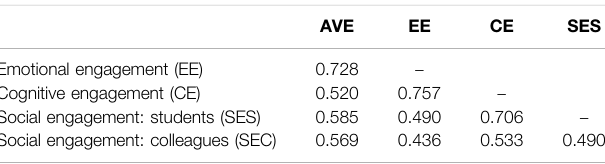
TABLE 1 | Convergent and discriminant validity of the initial 16-item model of C-ETS.